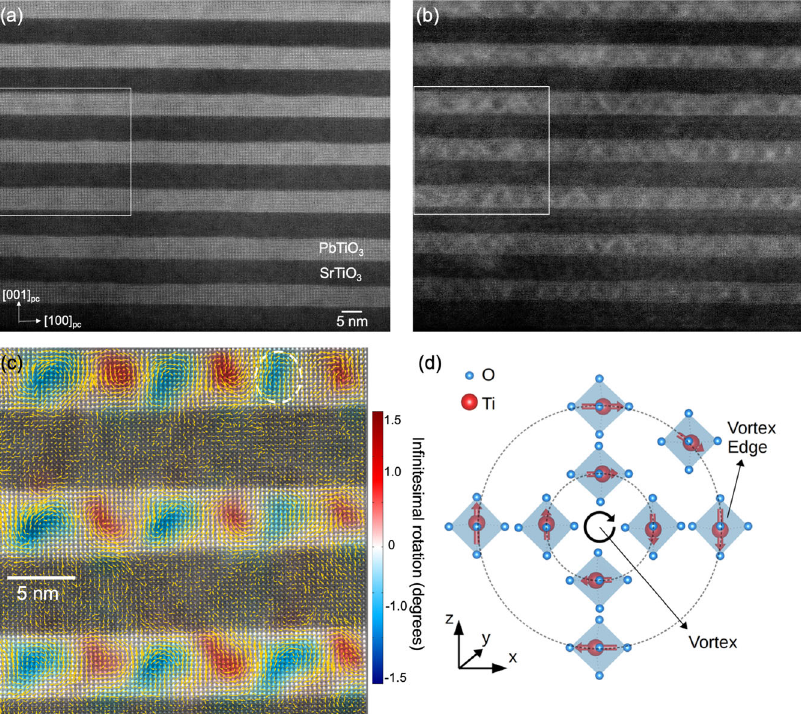
Fig. 1 Structure and Ti polarization orientation in polar vortices. a Cross-sectional HAADF- and b LAADF-STEM images of PbTiO 3 /SrTiO 3 superlattices. c A -site ( A : Pb or Sr) displacement vectors (yellow arrow) and curl of displacement (red/blue color) overlaid on the HAADF-STEM image. The color bar indicates the magnitude of the curl of the displacement vector. d Schematic representing the rotation of TiO 6 octahedra within one vortex domain.